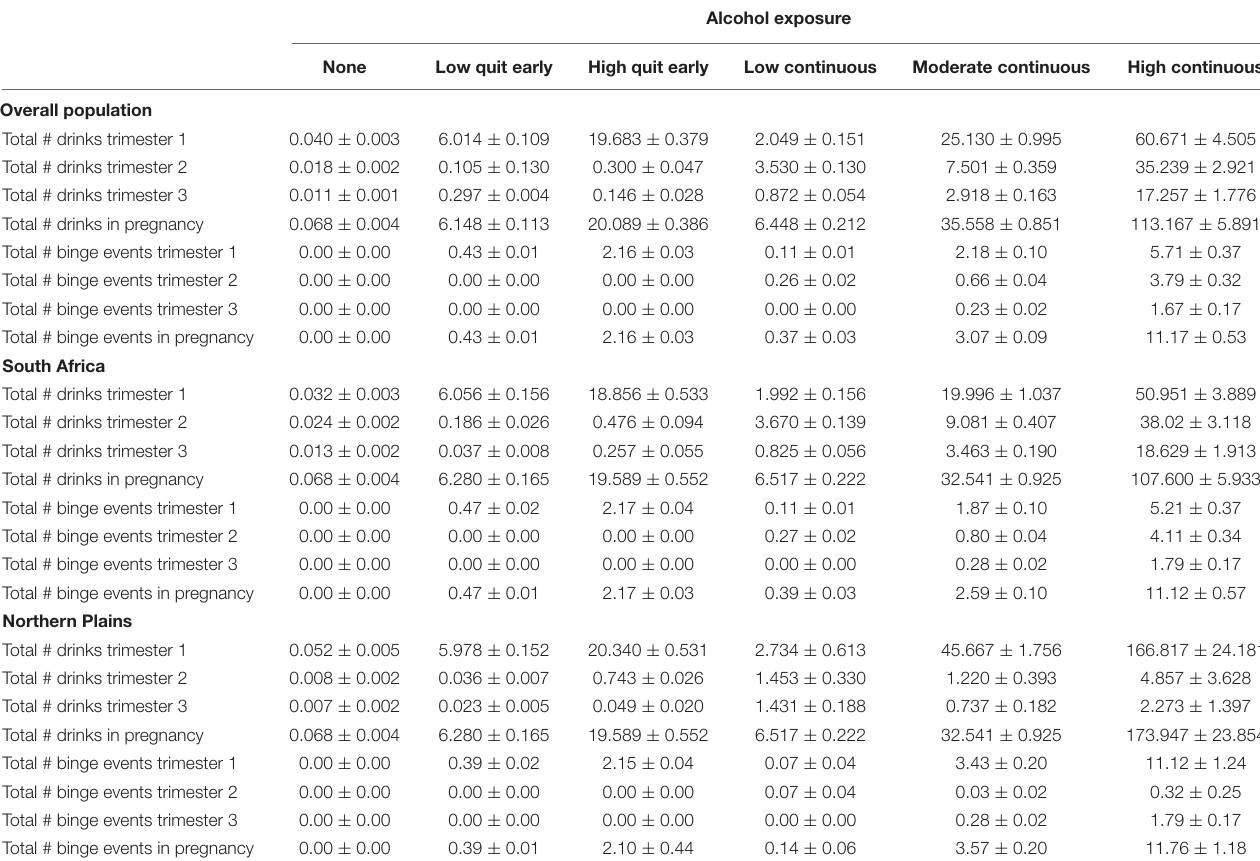
TABLE 3 | Number of drinks and binge events by trimester per alcohol group in the overall population, South Africa population, and Northern Plains population.